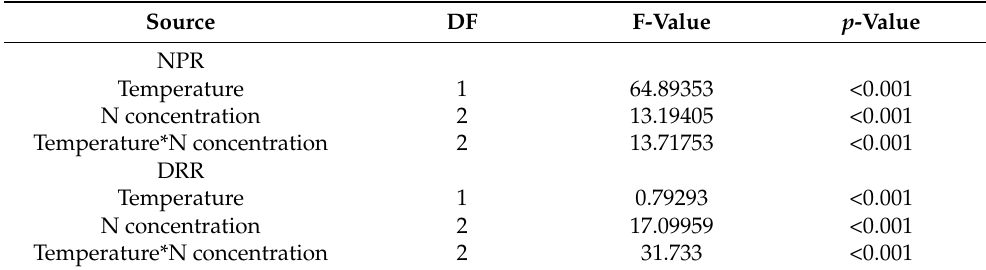
Table 5. Results of two-way ANOVA for net photosynthetic rate (NPR) and dark respiration rate (DRR) of S. horneri under LN, IN, and HN, treated by CT and ET.